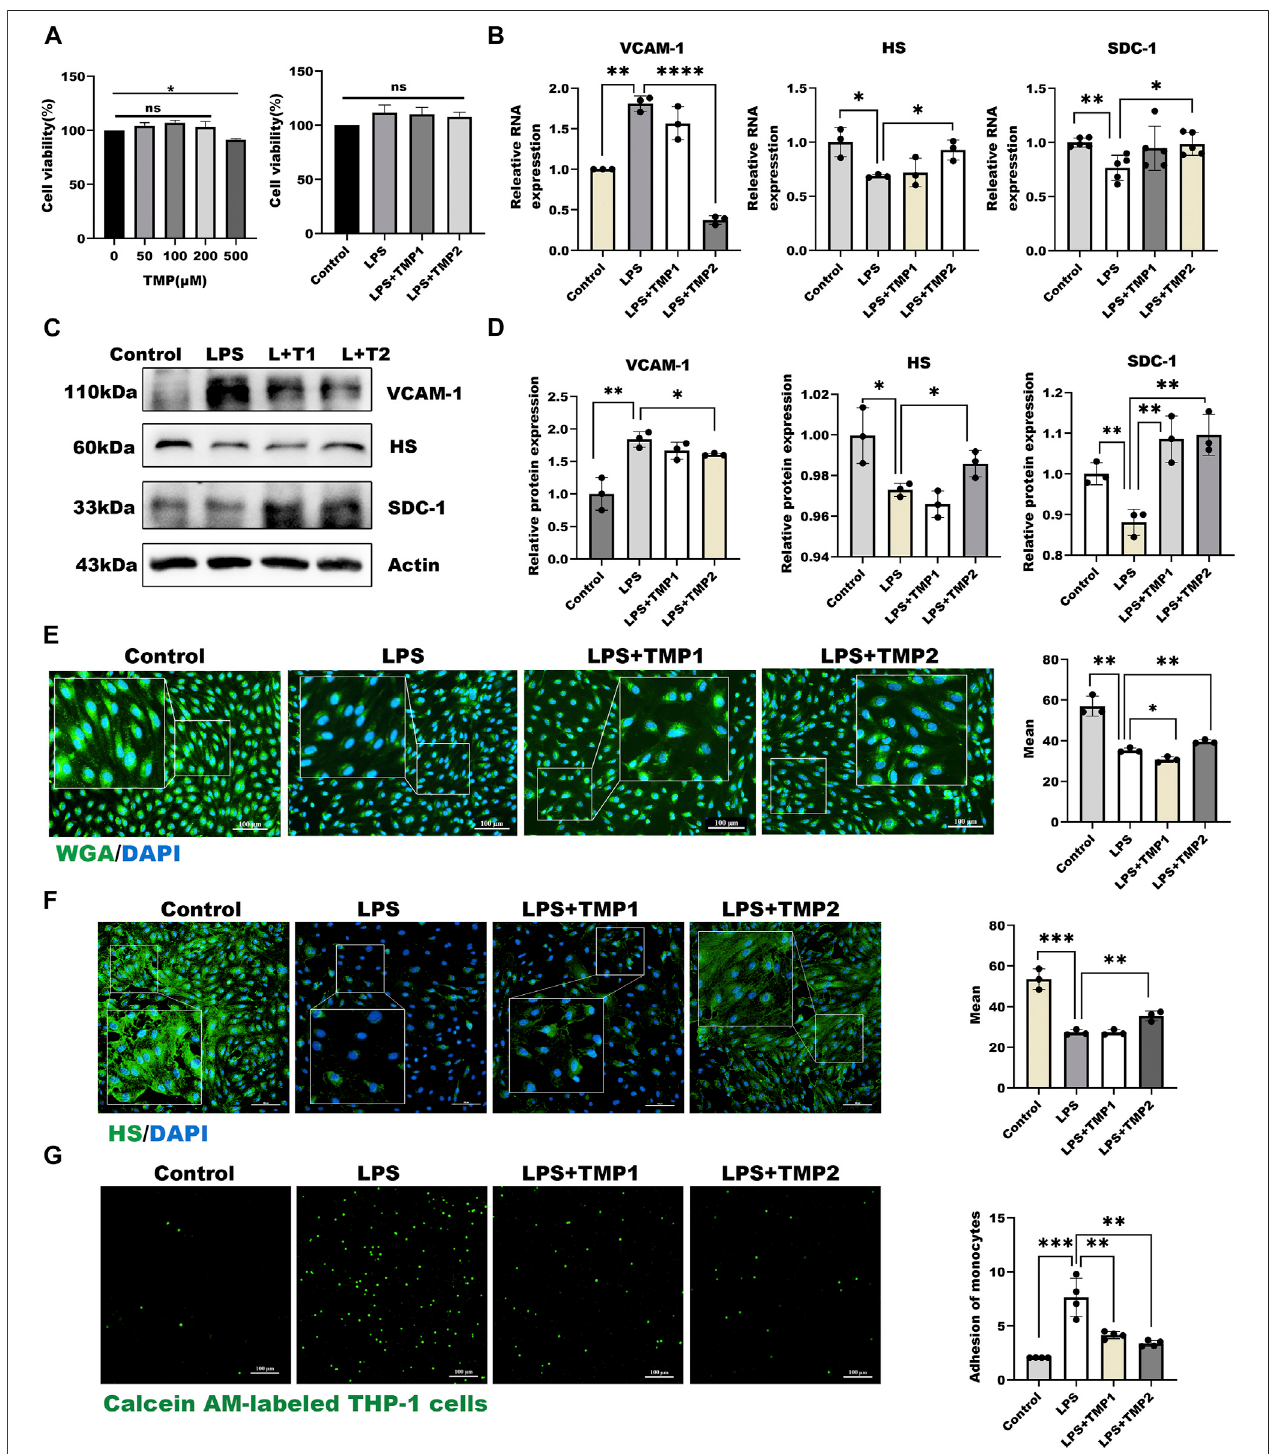
FIGURE 2 | TMP pretreatment protected glycocalyx degradation in LPS-induced in fl ammatory model (A) On the left are effects of HUVEC treated with TMP at differentconcentrationsoncellviability.OntherightareeffectsofTMP-LPSco-treatmentofHUVEConcellviability (B) Real-timePCRforanalysisoftheglycocalyxmajor components HS and SDC-1, in fl ammatory factor VCAM-1 mRNA levels after LPS and TMP stimulation in HUVEC (C) Western blot analysis of the glycocalyx major components HS and SDC-1, in fl ammatory factor VCAM-1 in HUVEC treated with LPS and TMP (D) Actin was used as an internal reference, and the gray value of proteinbandswasquanti fi edbyImageJ.Dataareshownasmean ± SD(n (cid:2) 3) (E) HUVECtotalglycocalyxlevelwerealsodetectedby fl uorescencemicroscopyanalysis